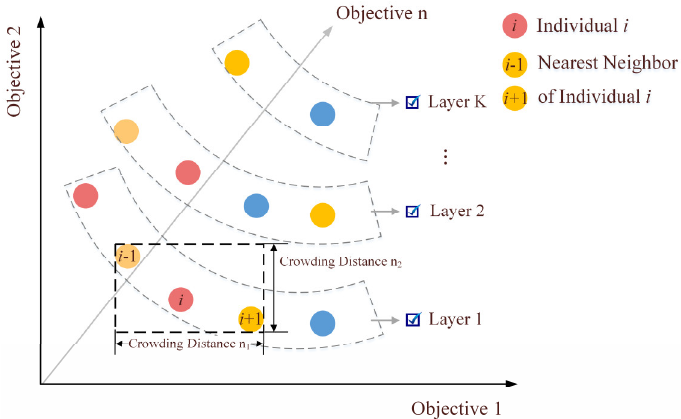
Figure 7. Fitness assessment of non-dominated sorting.